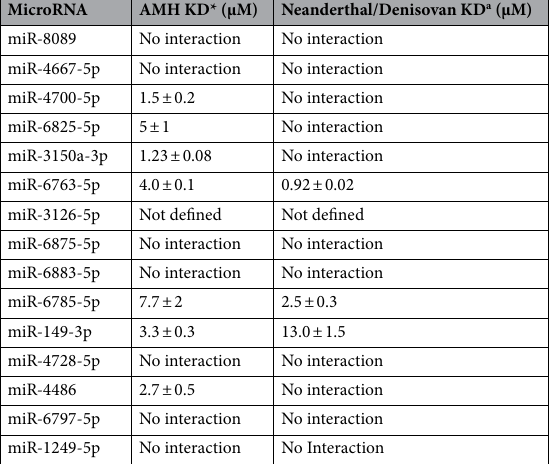
Table 1. Measure of the affinity by surface plasmon resonance. a KD: dissociation constants for each selected miRNA with the target sequences on the distal 3’UTR of AMH and Neandertal/Denisovan RUNX2